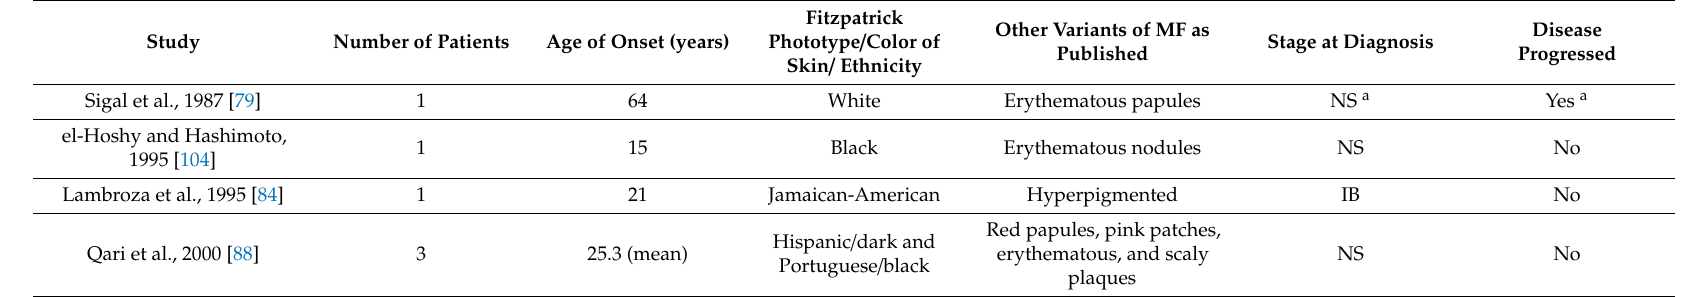
Table 2. Cases of hypopigmented mycosis fungoides concomitant with other MF variants. Cases published up to March